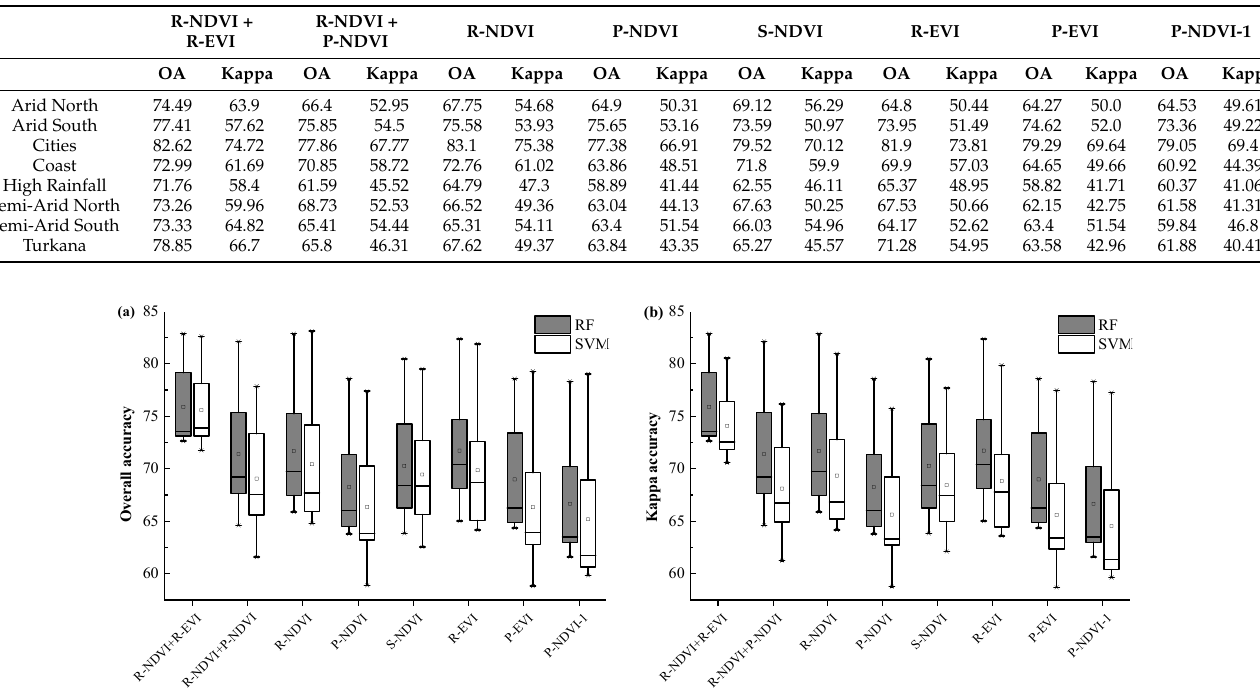
Figure 4. Box plot of classification accuracy for each dataset: ( a ) overall accuracy; ( b ) Kappa accuracy. Due to the difference of SVM and RF classification accuracy on various datasets Table 2. Accuracies (Overall Accuracy and Kappa Accuracy) were achieved for RF in different AEZs showing consistency, and because RF classifier had higher performance, we introduced and different datasets. only the RF results. As the most effective dataset for RF classifier, R-NDVI + R-EVI obtained the best results (OA = 82.86%) in cities, followed by Turkana (OA = 80.16%), arid south (OA = 78.14%), arid north (OA = 73.78%), coast (OA = 73.31%), high rainfall (73.24%), and semi-arid south (72.99%); semi-arid north had the lowest classification accuracy, with an OA of 72.63%. The classification maps of each AEZ were mosaicked together to obtain the LULC map of Kenya in 2018 (Figure